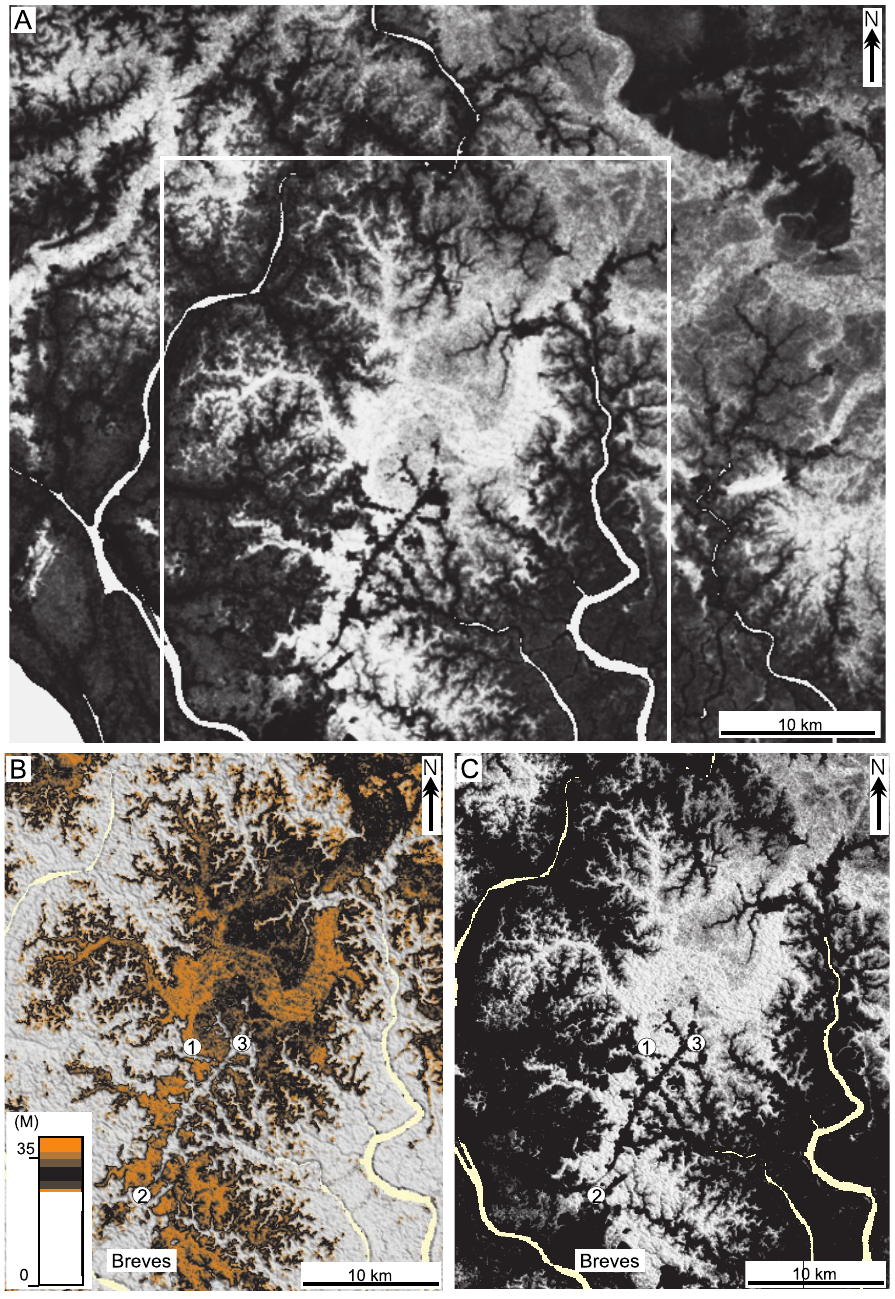
Fig. 2 – SRTM data from the study area, illustrating the sinuous belt with high elevation, attributed to paleochannels. A) A broad view of the study area in southwestern Marajó Island. Note the abundance of paleochannels, indicated by sinuous belts highlighted by bright to light gray tones, which correspond to higher digital topographic values than surrounding darker areas of lower topographies. The inside box indicates the drainage network with a large sinuous meander that is the object of this study. B and C) Details of the studied drainage network, highlighted with colors (B) and gray tones (C) (Gray scale in C as in A). Observe the perfectly preserved network of tributaries connected to the main meander, which resembles modern drainage systems. Note also that the main channel becomes progressively straighter to the south. Numbers indicate locations of drills #1 to 3, illustrated in Figures 3 to